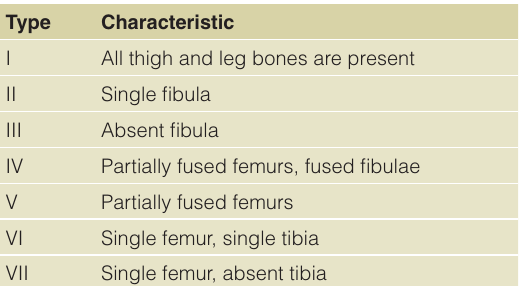
Table 1. Classification of the Sirenomelic sequence adapted from Stocker and Heifetz 13